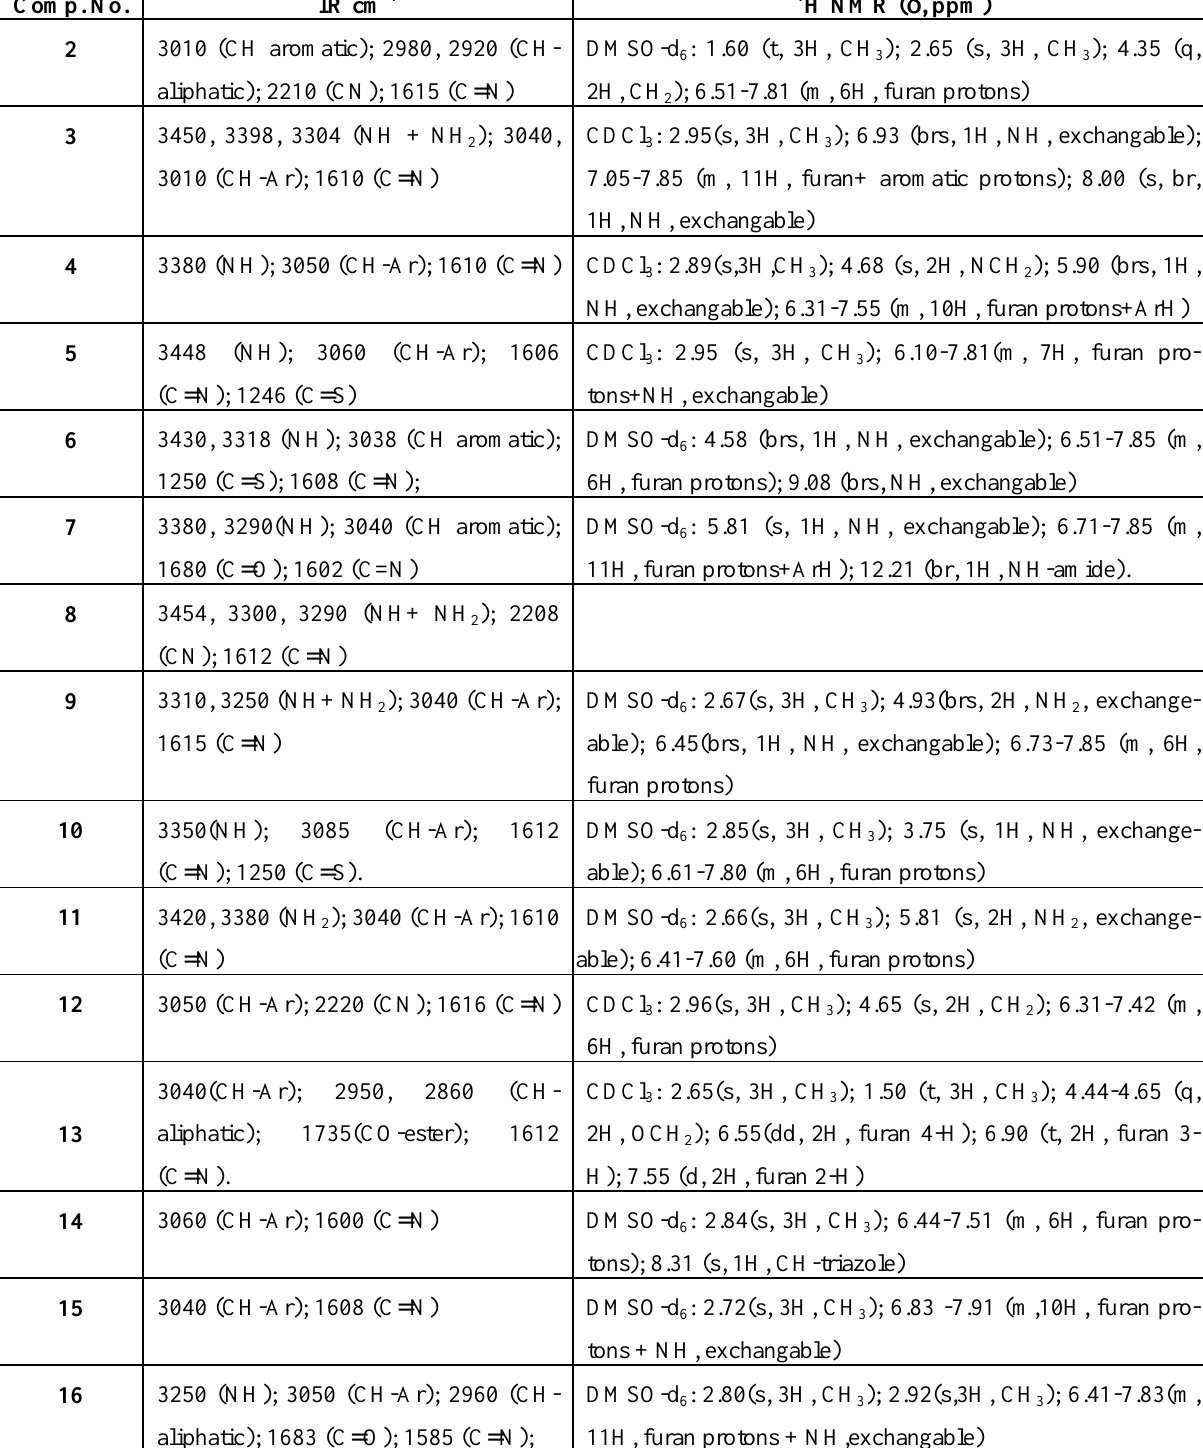
Table 2. Spectral data for selected